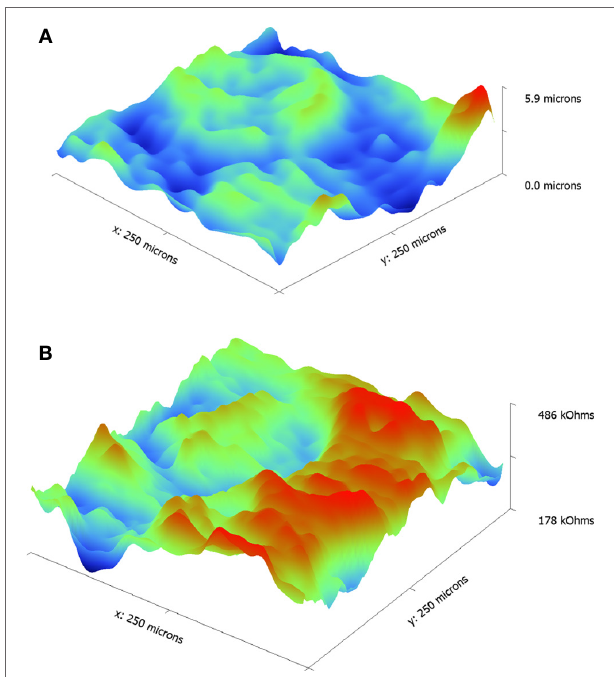
FigUre 6 | Topographic (a) and impedance (B) maps obtained on an llZO pellet using ic-ac-secM over a 250 μ m × 250 μ m area